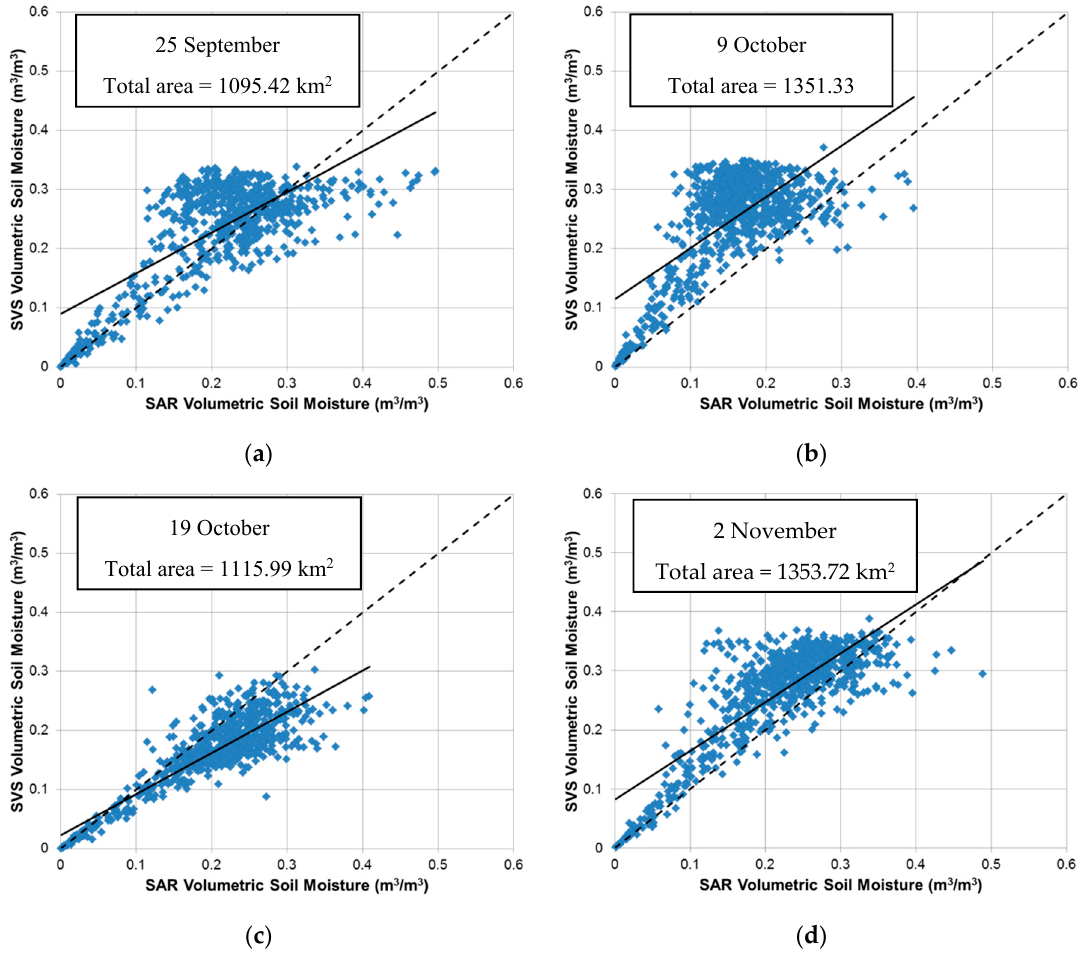
Figure 11. Scatterplots of the modeled (SVS) and estimated (SAR) soil moisture over clay polygons for ( a ) 25 September, ( b ) 9 October, ( c ) 19 October, and ( d ) 2 November. The dashed line is the 1:1 line and the solid line is the regression line. Each dot represents the average soil moisture modeled (SVS) and estimated (SAR) of each soil polygon. The total area of the clay polygons in square kilometers is indicated in each plot.